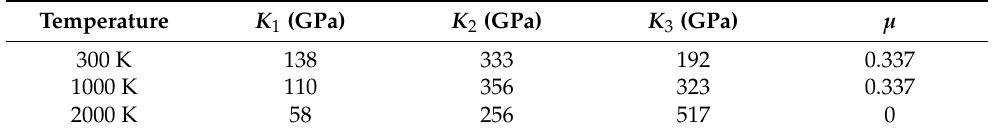
Table 1. Elastic constants: K 1 , K 2 , and K 3 are the coefficients of the pressure-volume relation deter- mined with the used interatomic potential proposed in [34]; µ is the Poisson’s coefficient. Temperature K 1 (GPa) K 2 (GPa) K 3 (GPa) µ 300 K 138 333 192 0.337 1000 K 110 356 323 0.337 2000 K 58 256 517